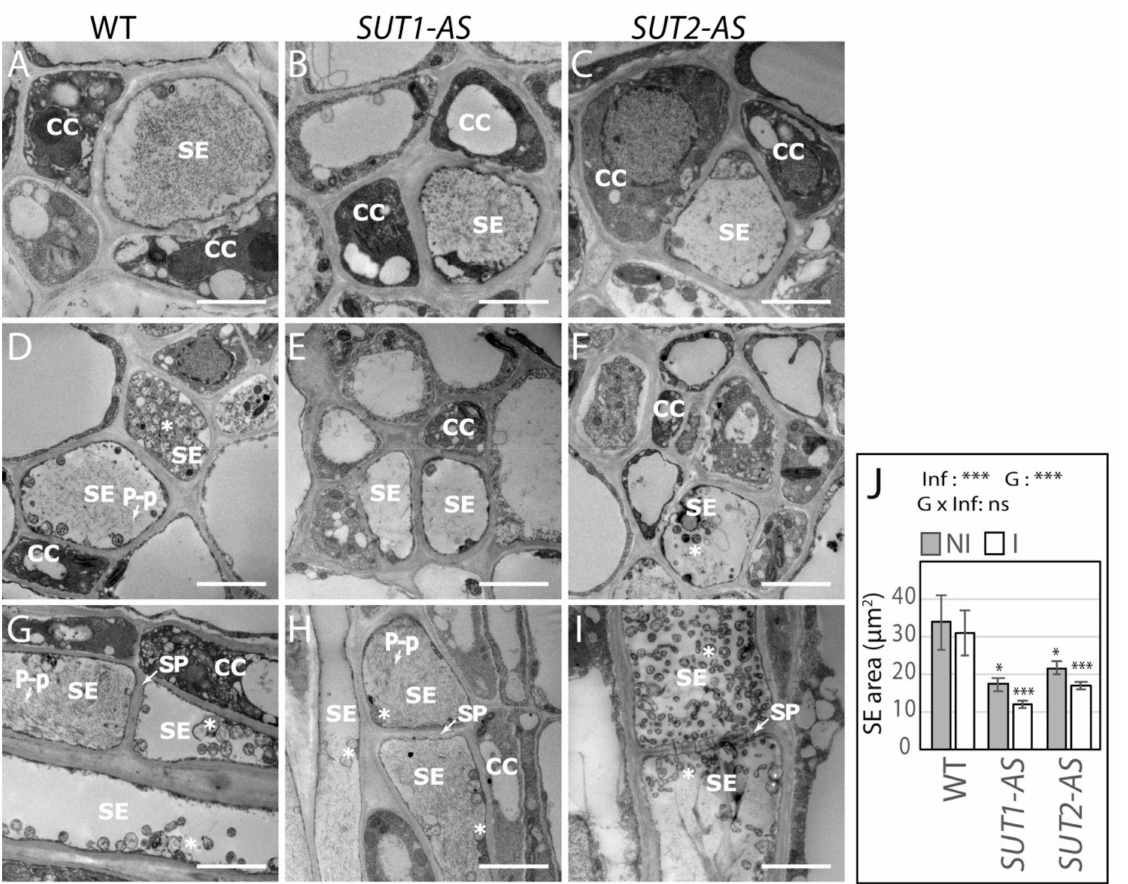
Figure 3. Ultrastructure of the phloem in response to the infection in the L1 leaf. ( A – I ): Transmission electron (TEM) images of the phloem in noninfected (NI) ( A – C ) and infected (I) ( D – I ) plants. Images are representative of the sieve elements observed, with n = 11–29 for healthy plants and n = 63–73 for infected ones, with 58 SE in total observed for healthy and 200 SE in total for infected plants. ( A , D , G ) WT, ( B , E , H ) SUT1 -AS plants and ( C , F , I ) SUT2 -AS plants. ( A – F ) Transversal sections and ( G – I ) longitudinal sections. * Phytoplasma, CC: companion cell, SE: sieve element, SP: sieve plate (white arrows in ( G - I ) and P-p: P-proteins (white arrows in ( D )). Scale Bars, 2.5 µ m. ( J ) SE cross-sectional areas in the phloem of not infected and infected plants, determined from TEM images ( n = 8–22). Asterisks above the bars indicate significant differences by a t -test in SUT1 - or SUT2 -AS plants compared to WT plants in the same genotype. The effects due to the infection (Inf), genotype (G) and their interaction (G x Inf), determined using a two-way ANOVA, are reported above the plot (* p < 0.05 and *** p < 0.001; ns, not